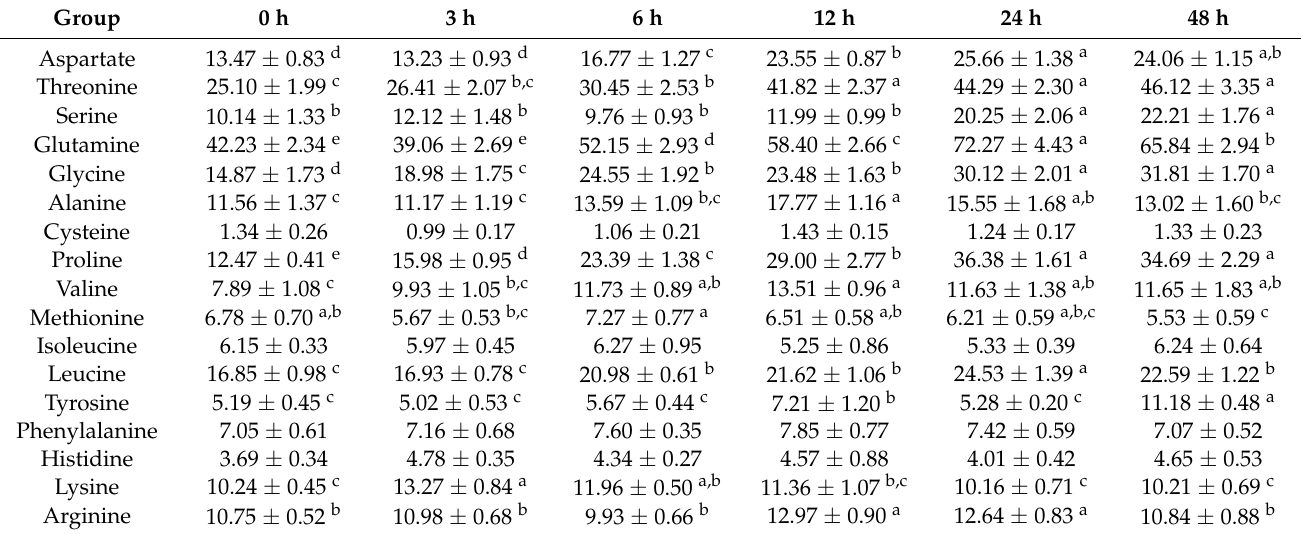
Figure 3. Effects salinity stress on hemolymph protein and FAA contents: ( A ) total free amino acid (TFAA) content in hemolymph; ( B ) essential amino acid (EAA) content in hemolymph; ( C ) Non- essential amino acid content in the hemolymph. Data were expressed as mean ± SD ( n = 6). Different letters indicate statistical differences ( p < 0.05) between the groups. Table 1. Content of 17 free amino acids in the hemolymph (mg/L) of S. oleivora .